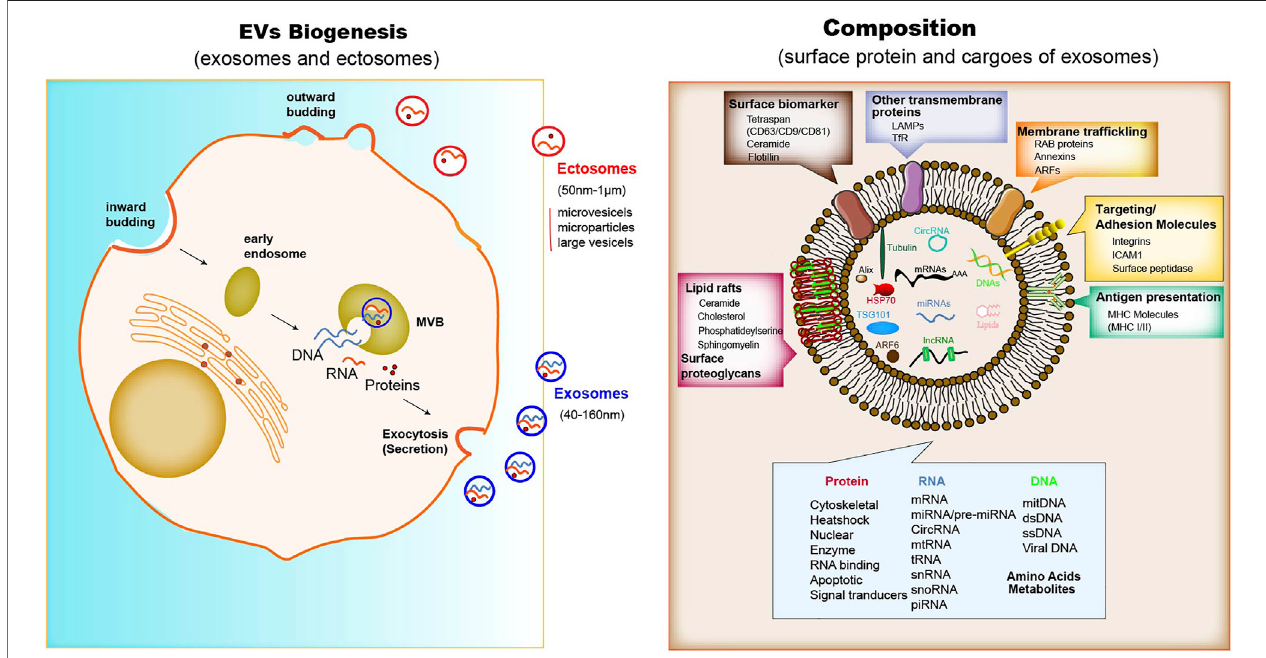
FIGURE 2 | The Biogenesis, composition and function of exosomes. When MVBs fuse with the plasma membrane, exosomes are released (size range ∼ 40 – 160 nm),whichwerethenendocytosedbyphagocyticmechanismorthereceptor-ligandinteractionwiththedonorcell.Themembraneofexosomesisenrichedin tetraspanins, small transmembrane proteins that are crucial for trapping both membrane and luminal proteins. The common protein repertoire in exosomes derives mostly from the expression of endosomal markers (including surface biomarkers such as the tetraspan family (CD63/CD9/CD81), ceramide, and fl otillin; other biomarkers such as Alix, ARF6 and TSG101), transmembrane proteins, MHC molecules, targeting and adhesion molecules (ICAM1, EpCAM), integrins, and surface peptidases. Nucleic acids comprise mRNAs, miRNAs, lncRNAs and cirRNAs, Lipid rafts contain ceramide, cholesterol, phosphatideylserine and sphingomyelin, and other surface proteoglycans. The adhesion protein ICAM-1 appears to be present only in the exosome membrane. The membrane of ectosomes is abundant in some receptors, glycoproteins and metalloproteinases. The cargoes trapped within the EVs contain many proteins and types of nucleic acids. Upon release, the two types of vesicle navigate through extracellular fl uid for varying times and distances. Cargo proteins are: cytoskeletal and associated proteins, such as actin, vimentin, talin and annexin; a few chaperones, such as Hsp70 (a chaperone that protects the structure and function of proteins) and Hsc70; and a number of enzymes, such as phosphoglyceratekinase1(PGK1)andglyceraldehyde-3-phosphatedehydrogenase(GAPDH).VariousGTPases,suchasARF6,areinvolvedintheregulationoftheILV assembly